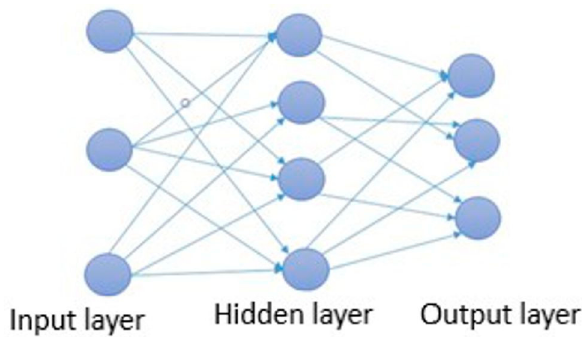
Figure 1. Representation of a neural network (ANN). Figure 1 . Representation of a neural network (ANN) .